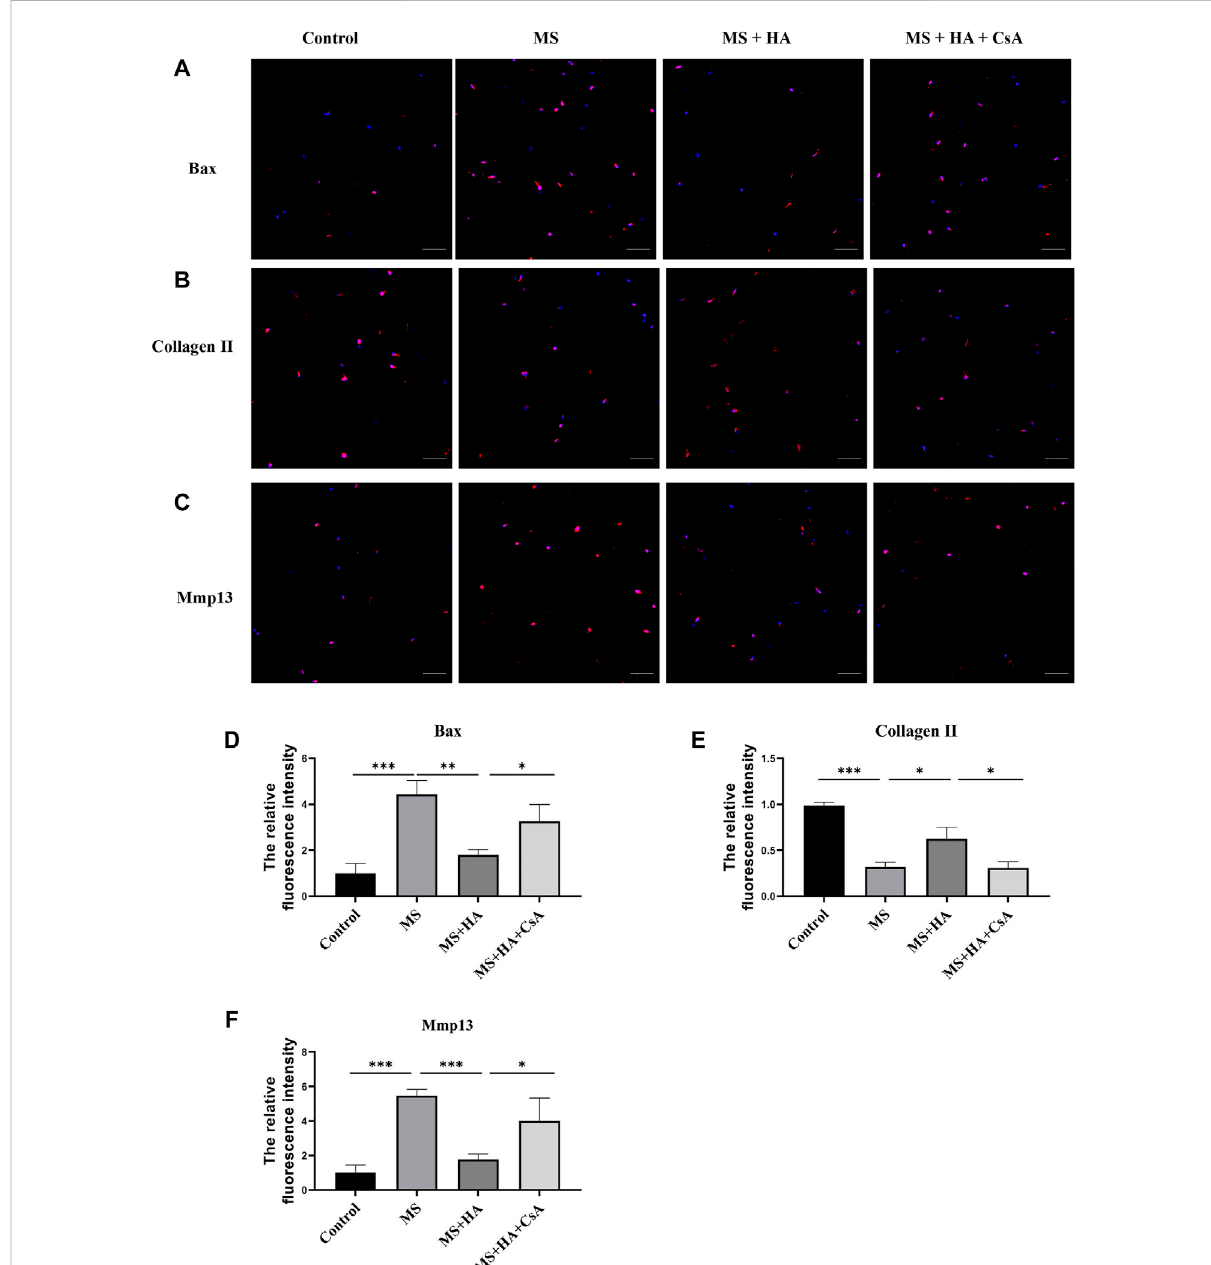
FIGURE 6 HA ameliorates NPCs apoptosis and ECM degradation in organ culture model. In organ culture model, bovine IVDs were received one strike loading and injected HA or CsA. (A – D) The protein expression of Bax was detected by the immuno fl uorescence staining. (B – E) The protein expression of Collagen II was detected by the immuno fl uorescence staining. (C – F) The protein expression of Mmp13 was detected by the immuno fl uorescence staining. Data are represented as the mean ± SD. p < 0.05, ** p < 0.01, *** p < 0.001. Scale bar: 50 μ m n =